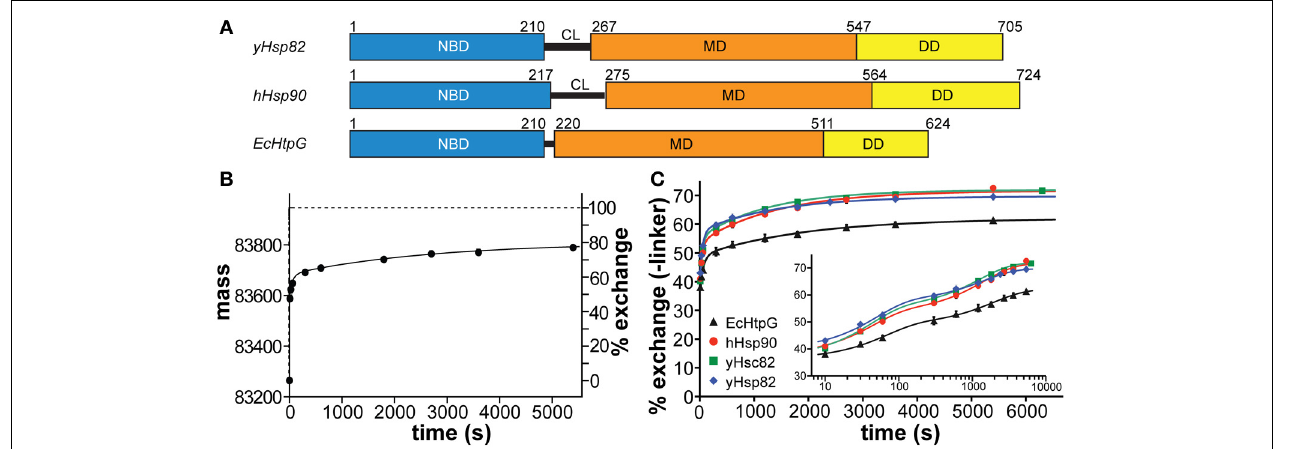
back-exchange during the desalting process calculated for the completely unfolded Hsp90 protein using the HXPep program (courtesy of Z. Zhang). (C) HX kinetics of full-length hHsp90 (black circles), yHsc82 (green squares), yHsp82 (blue diamonds), and EcHtpG (black triangles; data from (Graf et al., 2009) for comparison). Relative exchange minus the amide hydrogens of the linker [(H t –H linker )/(H total –H linker )] is plotted vs. the time in D 2 O. The data points are averages of two to four independent measurements. The error bars represent standard error of mean. The solid lines are the fits of a bi-exponential equation [Y = Y 1 · (1 − exp( − k 1 · t)) + Y 2 · (1 − exp( − k 2 · t)) + Y 3 ] to the data. The inset shows the same data with a logarithmic time